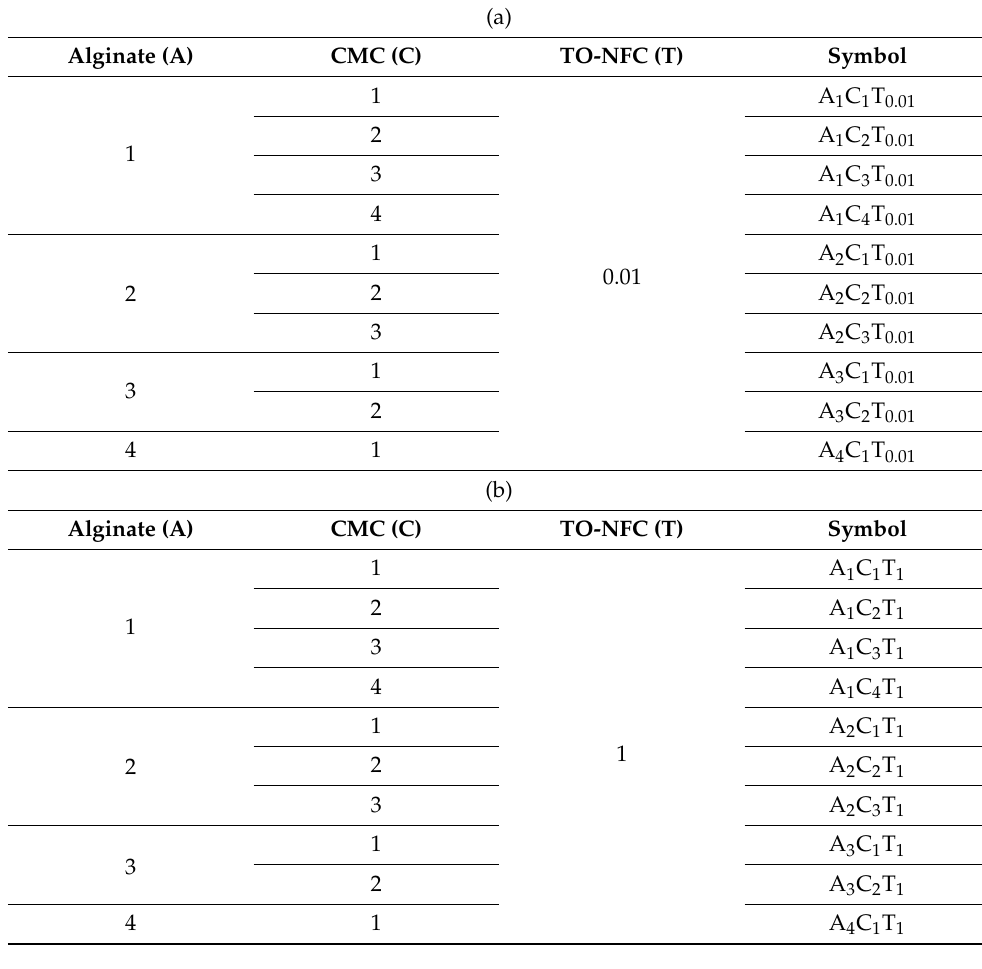
Table 2. Various compositions prepared with different weight percentages of alginate (1, 2, 3, and 4%, w / v ), CMC (1, 2, 3, and 4%, w / v ), and TO-NFC (0.01% and 1.0%, w / v